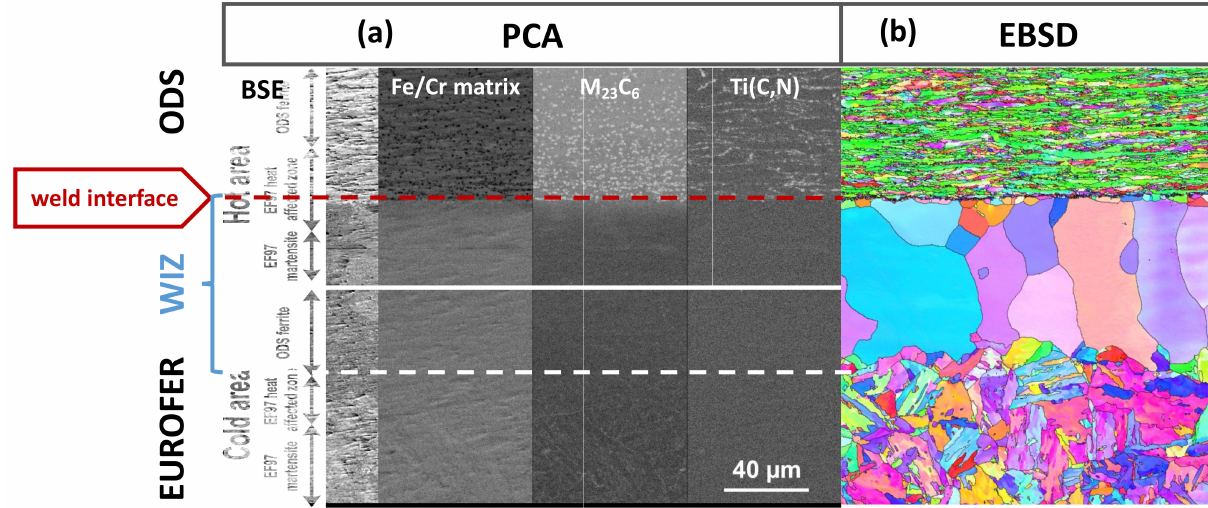
Figure 34. ( a ) Principal component analysis (PCA) of SEM-EDX data in the vicinity of channel A (see in Figure 33). It reveals the single phases, which are present in the respective sample areas. The weld interface and weld interface zone are indicated by dotted lines; ( b ) Electron backscatter diffraction (EBSD) analysis of the weld interface zone (WIZ). The density of Cr-rich precipitates in the ODS ferrite (white dots in the M 23 C 6 map) is increasing towards the interface. There are also Ti-rich precipitates in the ODS ferrite (white dots in the Ti (C, N) map), likely at grain boundaries. In addition to PCA, we performed an EBSD analysis of the interface region. This reveals the typical martensitic structure of on top. Moreover, the coarse-grained WIZ appears now clearly in between and is fully distinguishable from the other